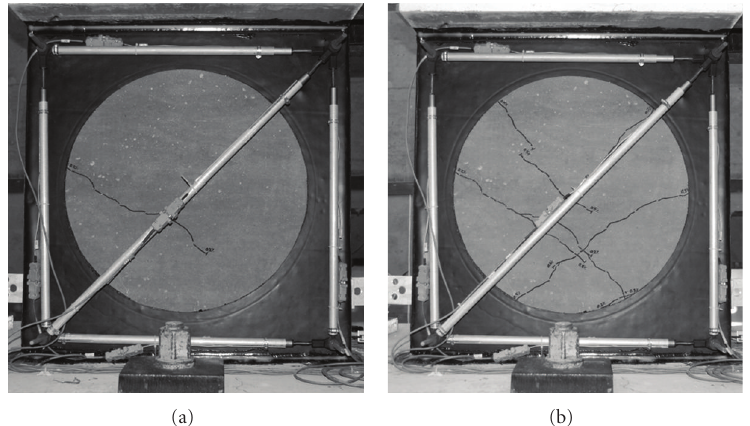
Figure 3: A laboratory biaxial test specimen under cyclic loading (a) at drift ratio of γ = 0 . 21% and (b) γ = 0 . 41% (images courtesy of Soppe and Hutchinson,